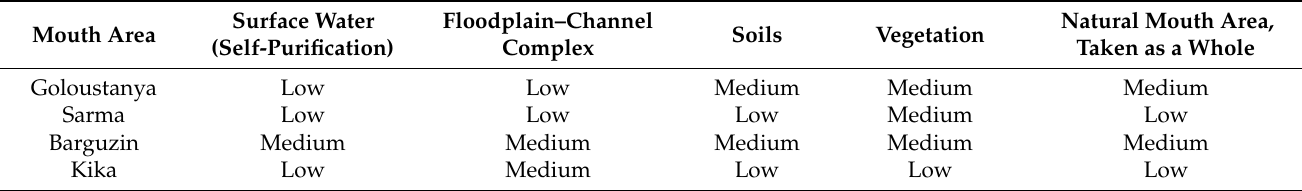
Table 3. Stability of surface water and landscape components of mouth areas to anthropogenic impact. Surface Water Mouth Area